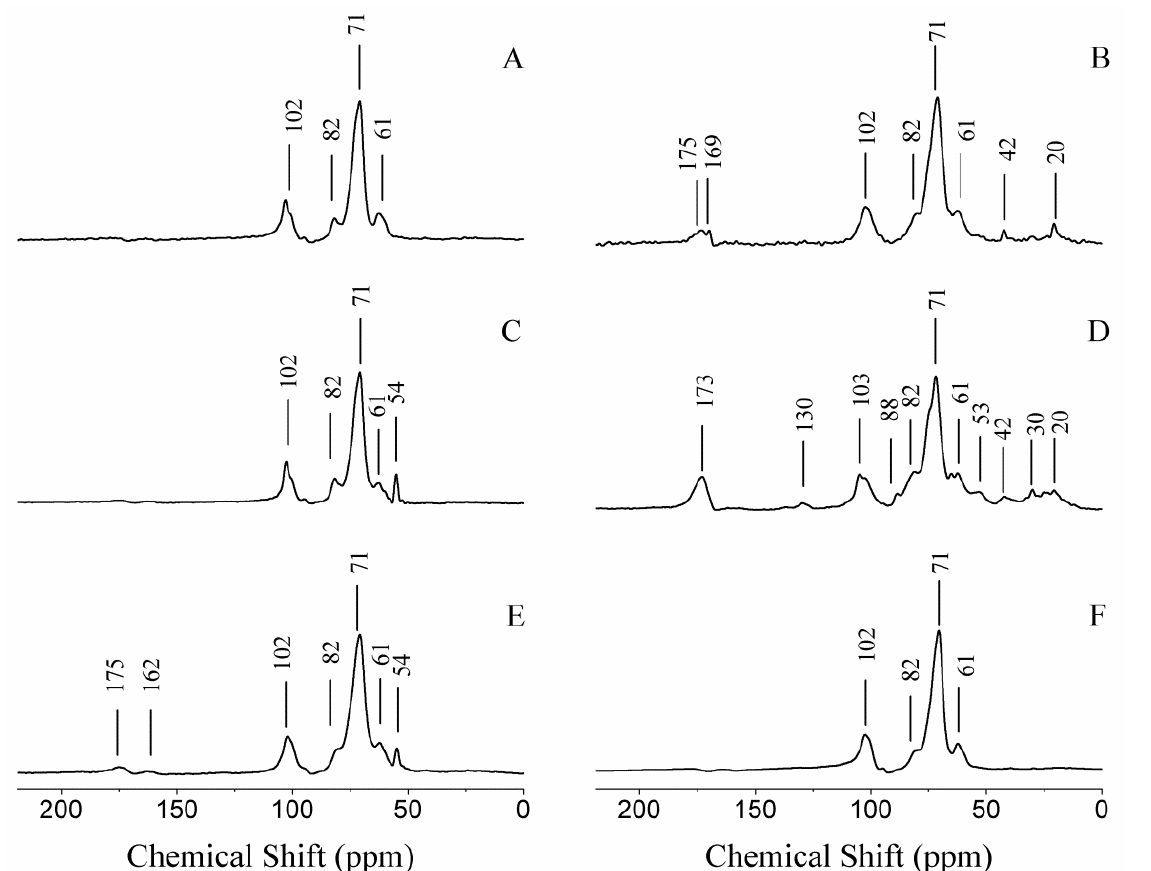
Figure 9. 13 C CP/MAS NMR spectra of ( A ) NG; ( B ) NG-MMT 3:1; ( C )